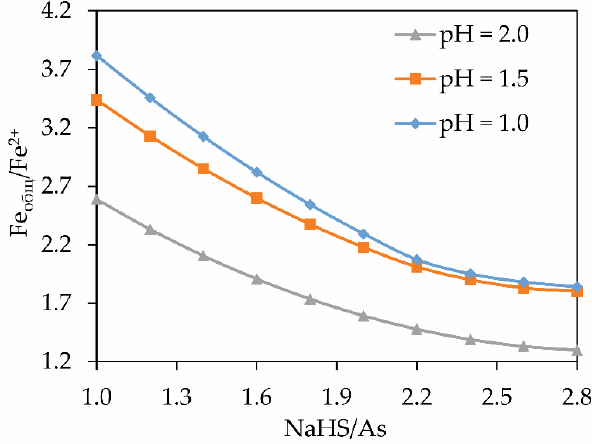
Figure 5. Dependence of the Fe total /Fe 2+ ratio on the molar ratio of NaHS/As at different pH values and 25 °C.